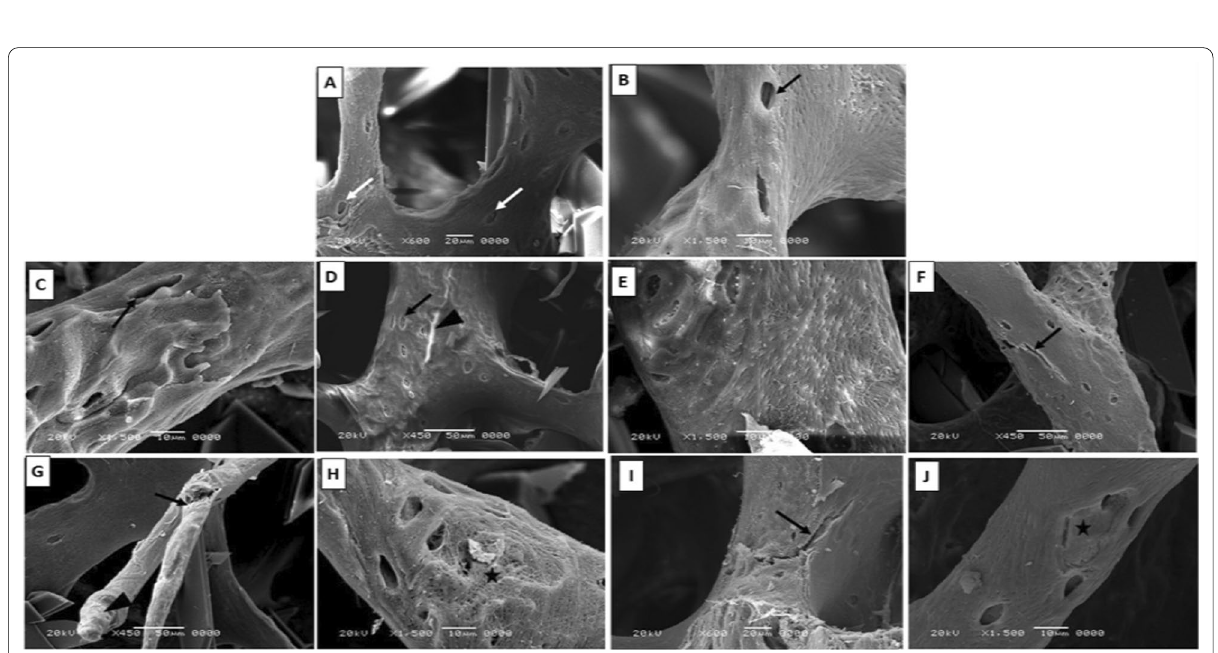
Fig. 9 Scanning electron microscopic examination of rat femur. Control group [A, B] A Branching and anastomosing bone trabeculae and osteocyte lacunae. B Collagen fibers are seen on the surface of bone trabecula. Osteocyte lacuna. ketamine treated group ( C ): Collagen fibers are seen on the surface of bone trabecula. Osteocyte lacunae ( ) are also seen. Tamoxifen treated group [D, E]: D A small crack is seen on the surface of ↑ bone trabecula. Osteocyte lacunae. E Collagen fibers on the bone surface. [F–H] Risperidone treated group ( F ) A crack is seen in a bone trabecula. G Thin tapering and fractured bone trabecula are seen. H Disturbed and disorganized collagen arrangement are seen on the surface of bone. [I, J] Combination treated group : I A crack is seen on the surface of bone. J Localized area of loss of collagen